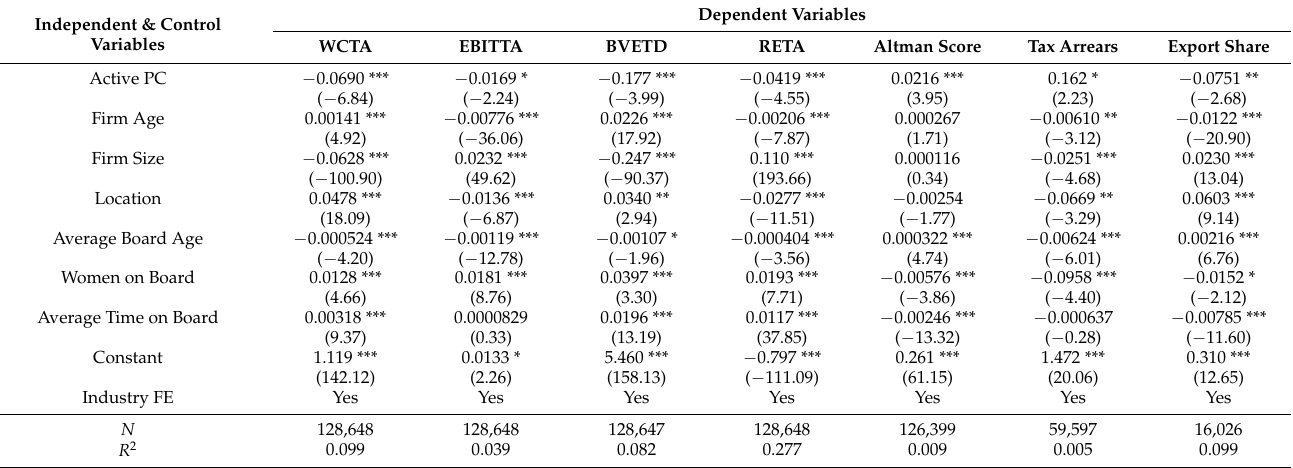
Table A3. OLS regressions with seven different dependent variables (year 2018) and Active PC as the independent variable.